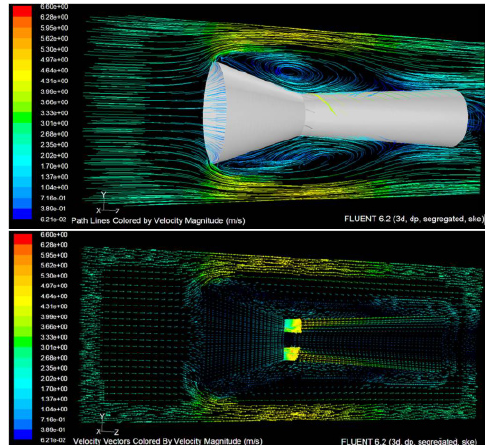
Figure 6. Path line diagram of a single CMMCT unit placed in a free flow of 2.5 m/s undisturbed flow speed.